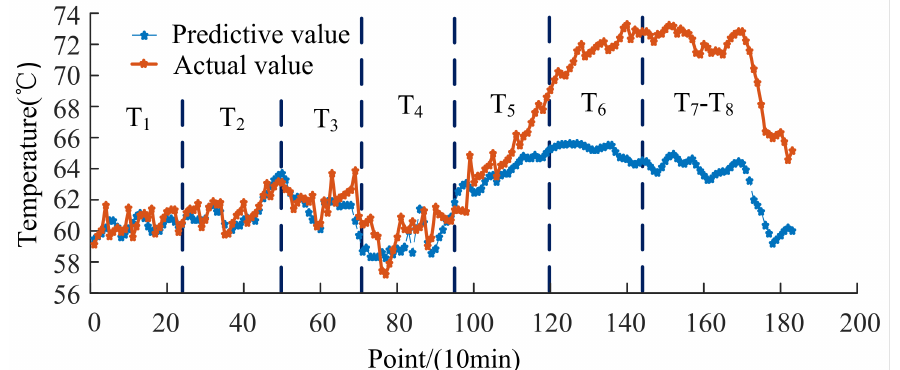
Figure 9. Actual and prediction value of gearbox bearing temperature.